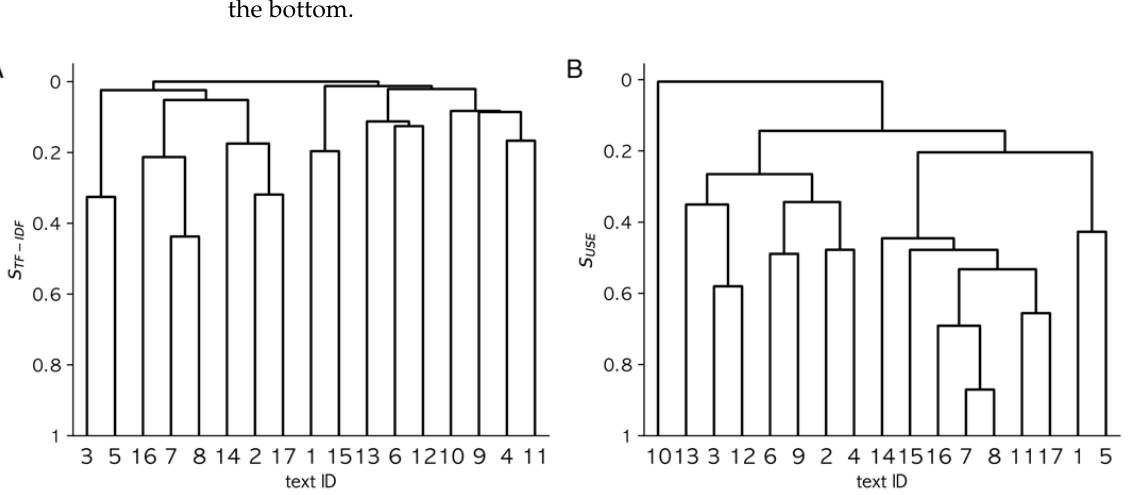
Figure 5. Dendrograms of clustering results using TF-IDF ( A ) and USE ( B ). TF-IDF and USE produced considerably distinct clustering results, except for a few texts. Texts 7 and 8 were the most similar in terms of TF-IDF and USE and were clustered to the same group by the first merge. This group comprising 7 and 8 was later merged